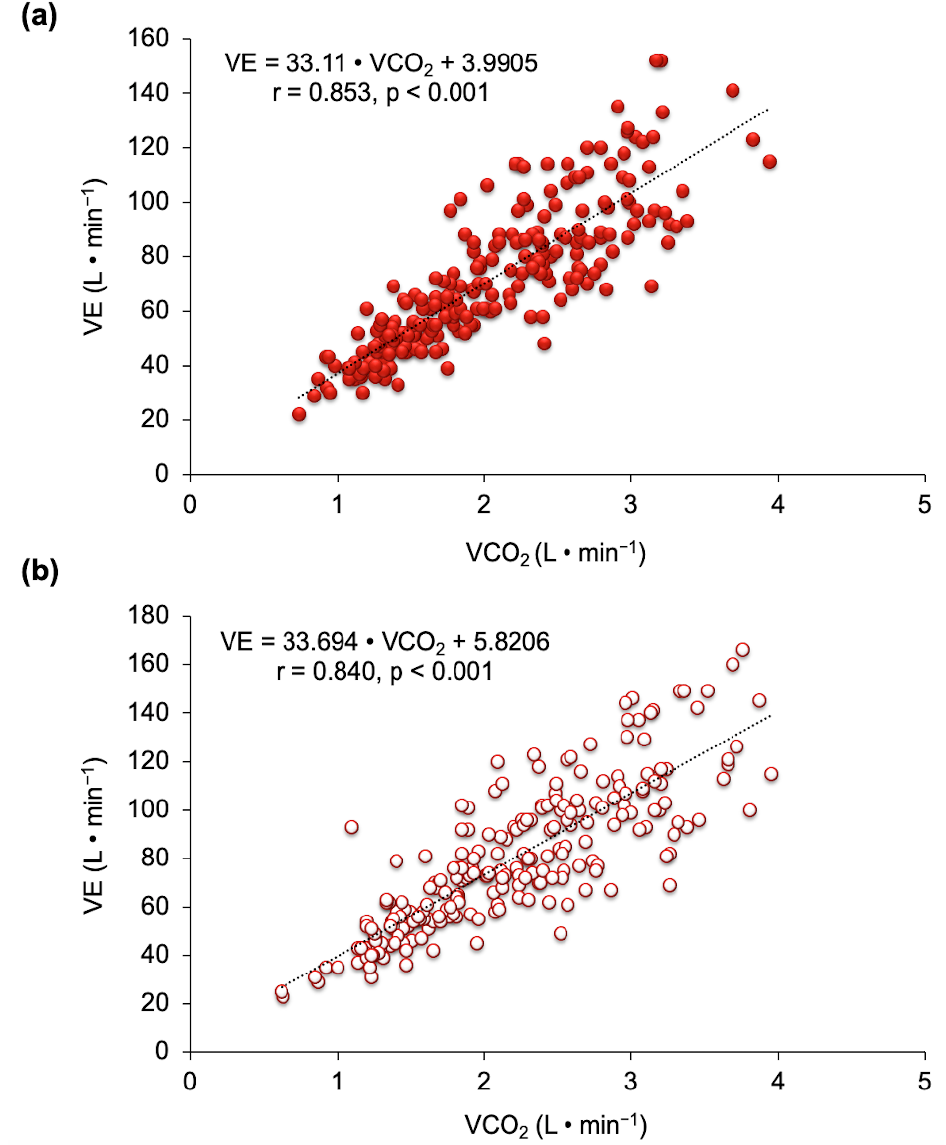
Figure 4. Relationship between ventilation (VE) and carbon dioxide (VE • VCO 2 − 1 slope) after beetroot juice ( a ) and a placebo ( b ) ( n = 11).